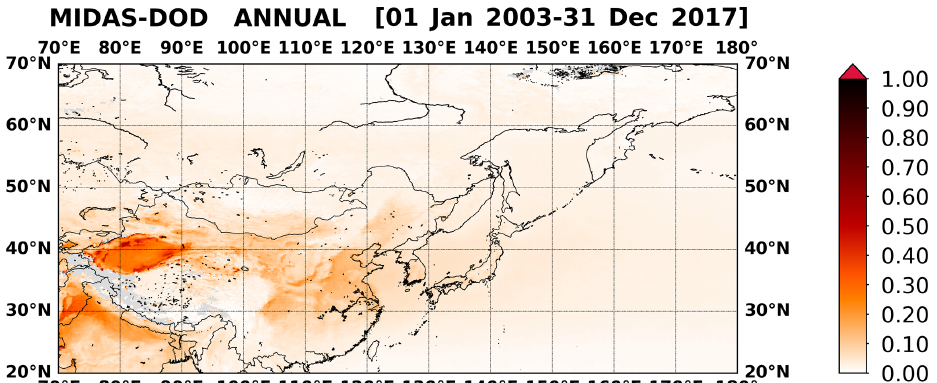
Figure 5. As in Fig. 1 but for East Asia and the North Pacific Ocean.